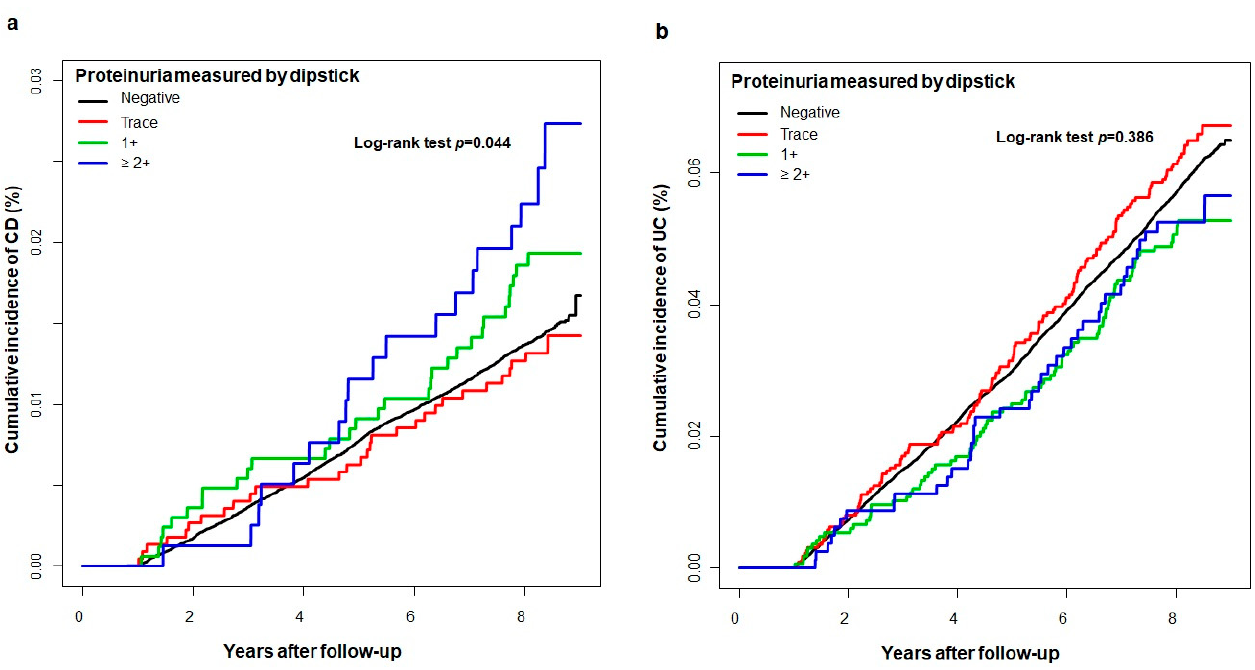
Figure 1. Kaplan-Meier curve for the cumulative incidence of Crohn’s disease ( a ) and ( b ) ulcerative colitis according to the degree of proteinuria measured by dipstick. CD, Crohn’s disease; UC, ulcerative colitis.